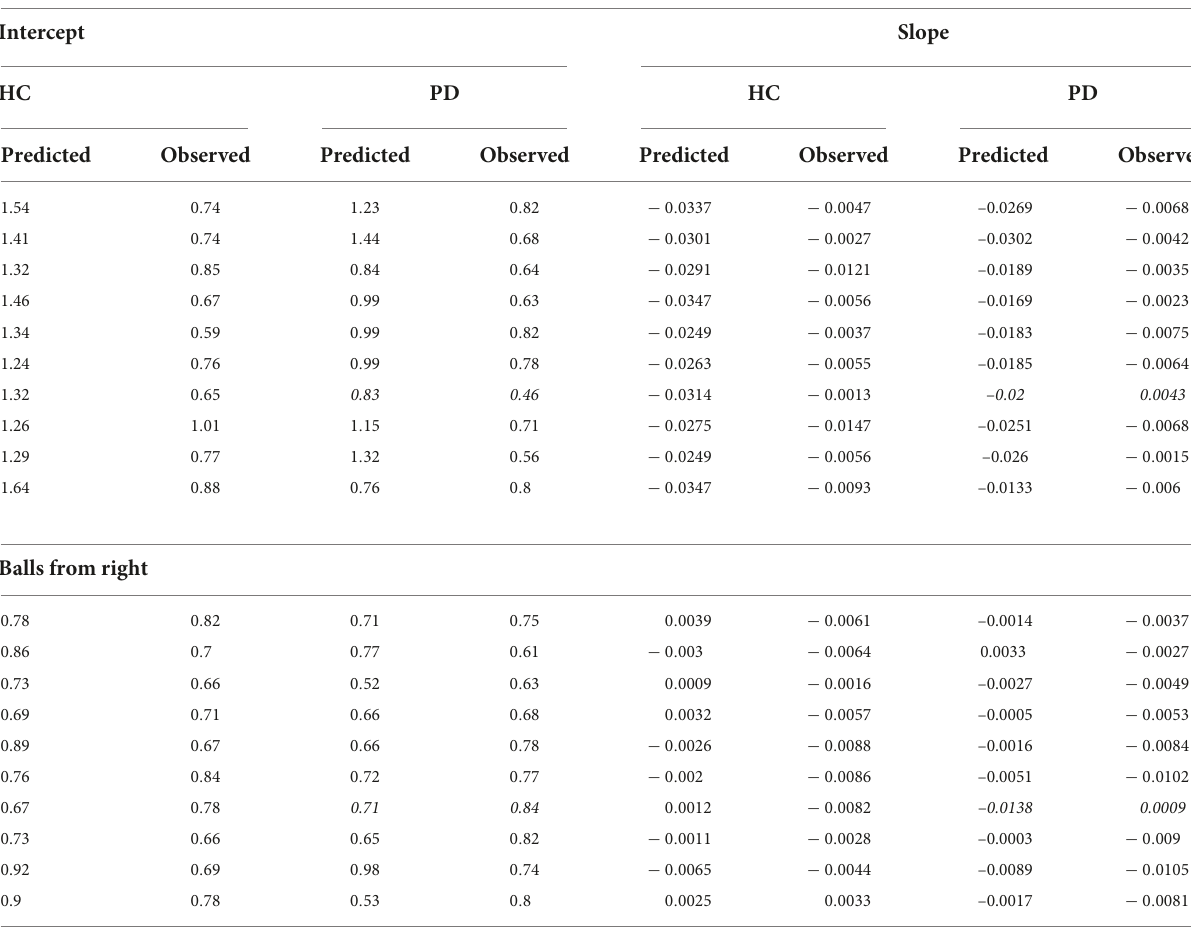
TABLE 3 Linear regression between switching time and required movement amplitude for the individual subjects. Balls from left Intercept